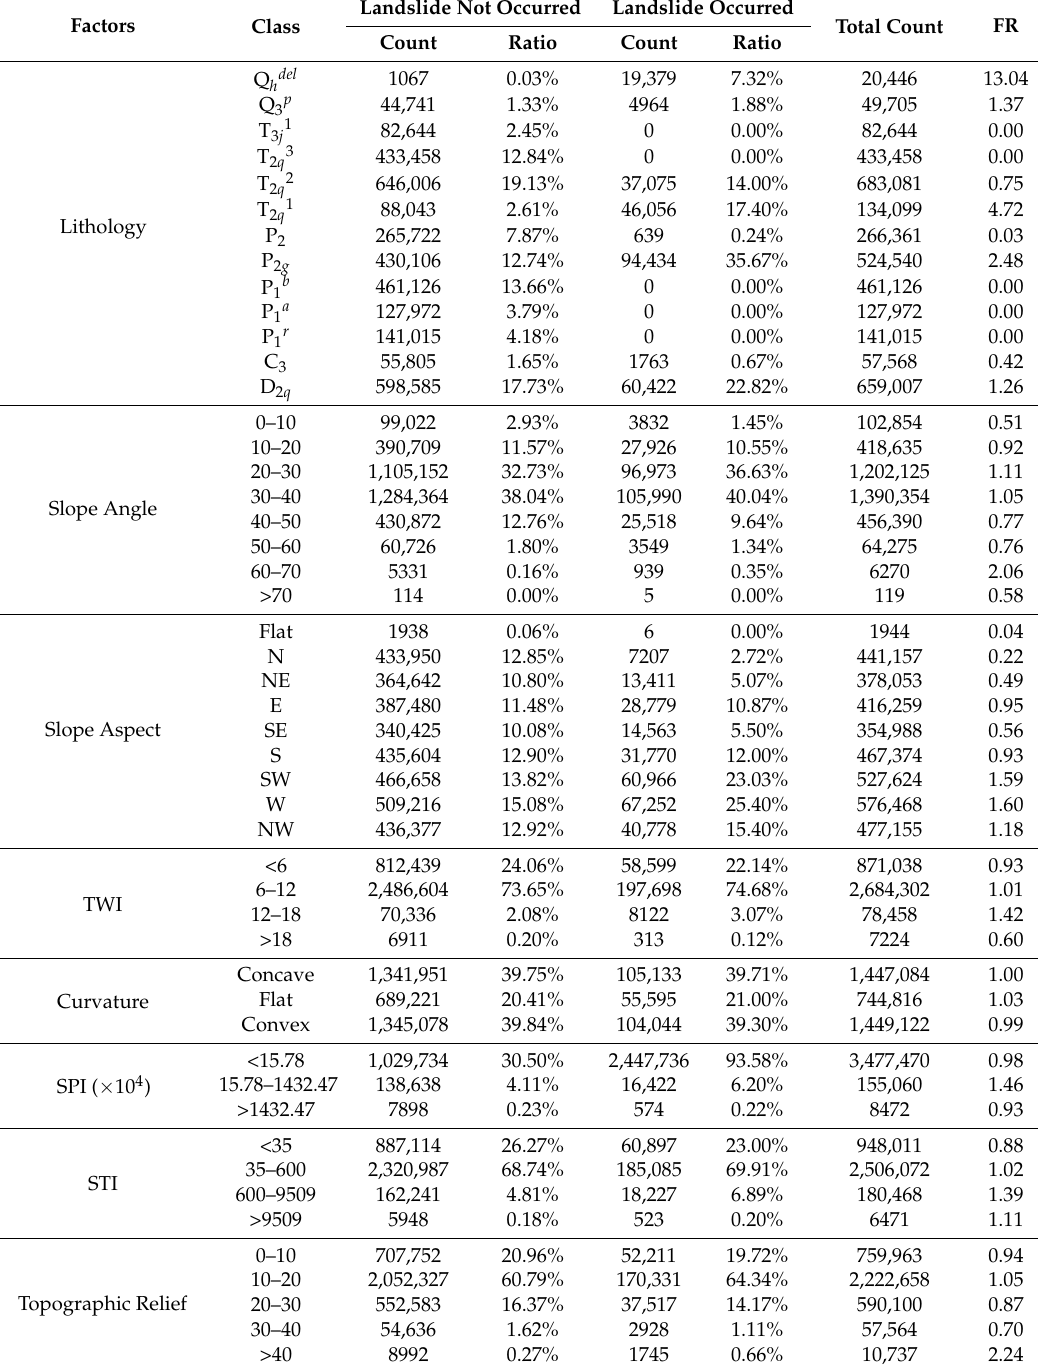
Table 2. Distribution of the training pixels. NDVI—normalized difference vegetation index; FR—frequency ratio; TWI—topographic wetness index; SPI—steam power index; STI—sediment transport index; NDVI—normalized difference vegetation